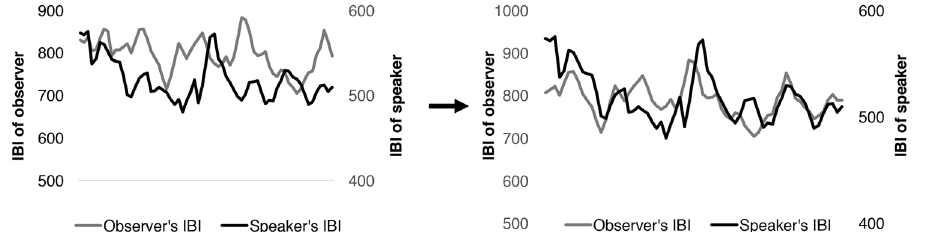
Figure 3. Visual representation of IBI data of observer from Fig. 2 watching a Stress video. The graph on the left shows how IBI of speaker and observer are related when no time lag is implemented. On the left, we see how IBI of speaker and observer are related when a time lag of approximately 8 seconds is applied. A secondary axis was created to help visualize differences in IBI, as the speaker was robustly stressed and as a result had a lower IBI compared to the